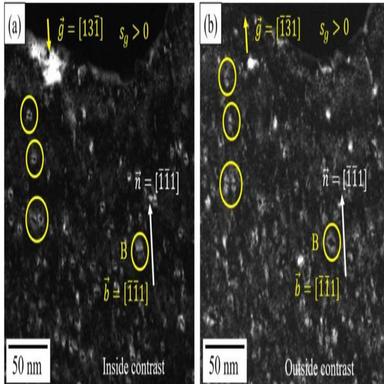
Weak beam dark field TEM images showing inside-outside contrast of dislocation loops in ThO2 after 0.47 dpa proton irradiation at 600oC obtained using zone axis and positive and negative g conditions: (a) and (b) , respectively.